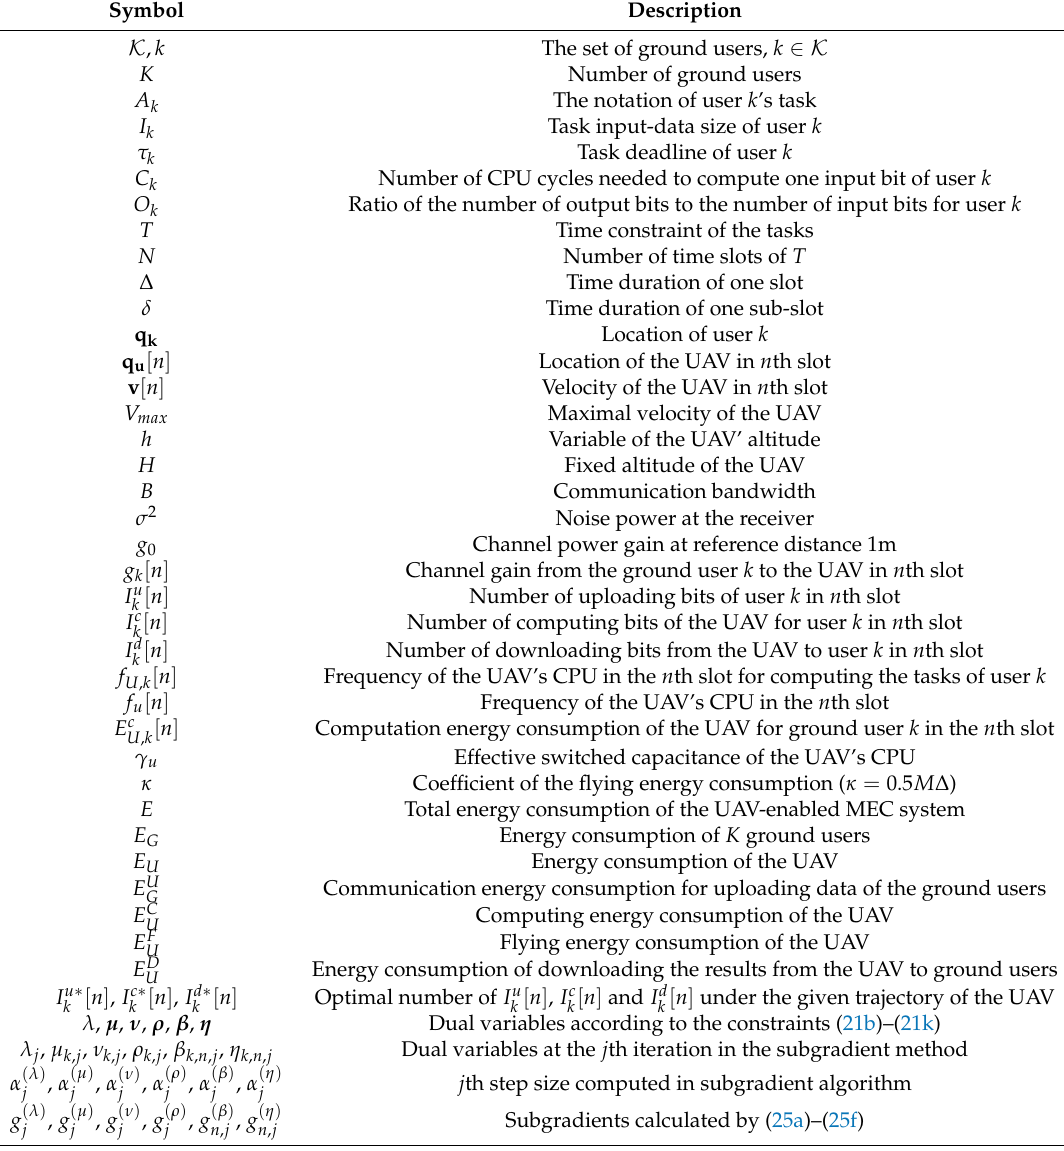
Table 1. List of